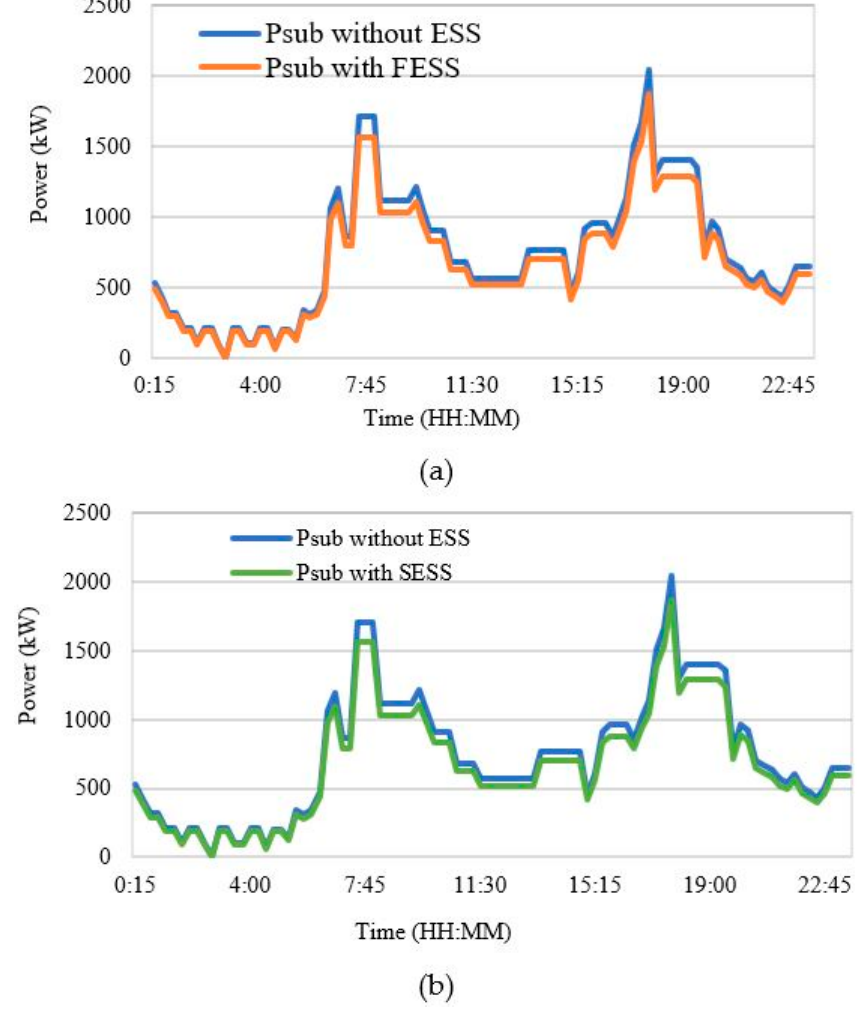
Figure 12. Substation peak demand reduction; ( a ) with flywheel ESS, ( b ) with supercapacitor ESS.